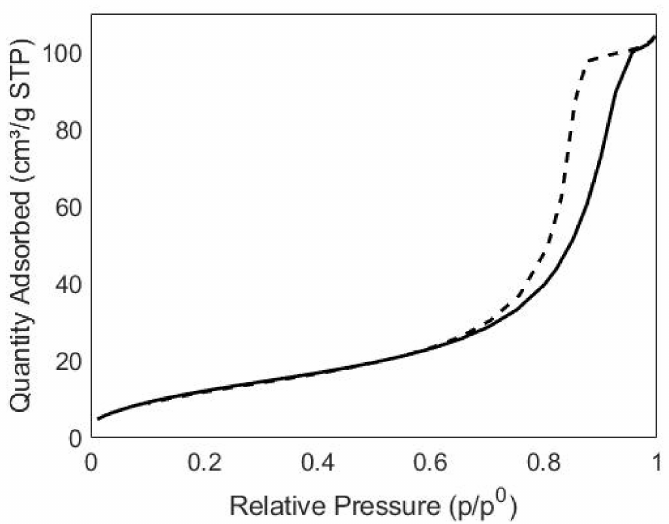
Figure 3. Nitrogen sorption isotherms (adsorption branch— desorption branch —) of n-ZnO.